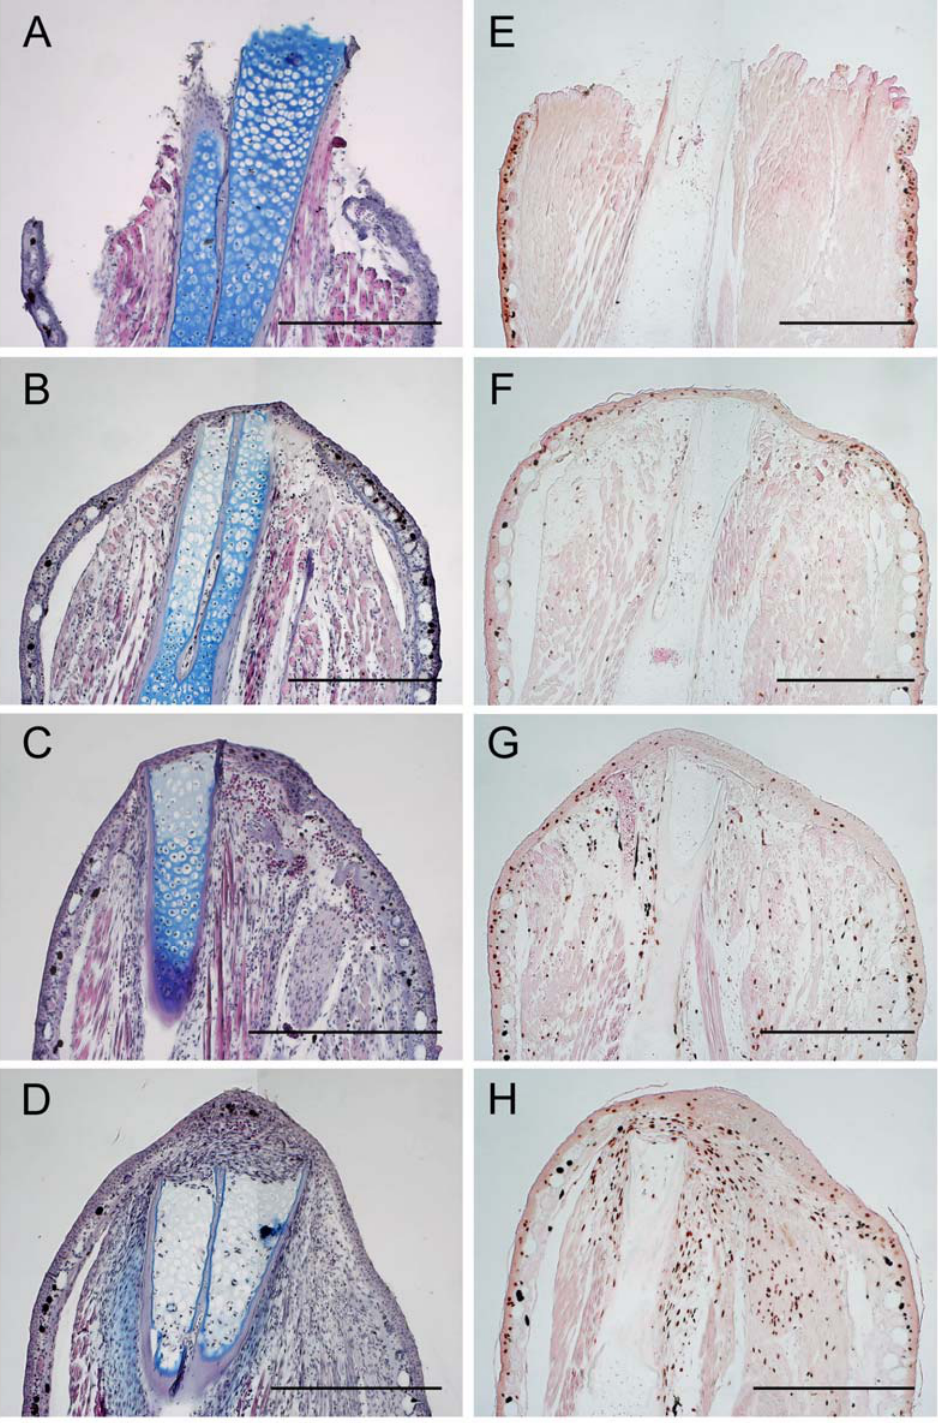
FIGURE 2. Histological observations of early limb blastema in the Xenopus froglet. Longitudinal sections of the froglet forelimb stumps were stained with hematoxylin, eosin and Alcian blue (A–D) or with anti-BrdU antibody and DAB (brown) after incorporation of BrdU for 1 h (E–H). (A,E) 0 days, (B,F) 1 day, (C,G) 2 days, (D,H) 4 days after amputation. Specimens were fixed in Bouin’s fixative, embedded in paraffin, and sectioned at a thickness of 6 μ m. The procedures for the BrdU treatment and immunohistochemistry were essentially the same as that of Suzuki et al.[37]. Scale bars = 400 μ